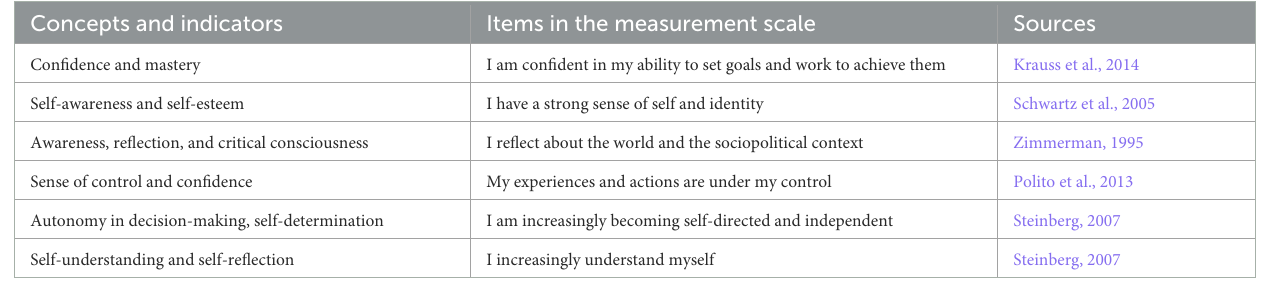
TABLE 2 Nomological network for the construct sense of purpose: youth purpose scale. Concepts and